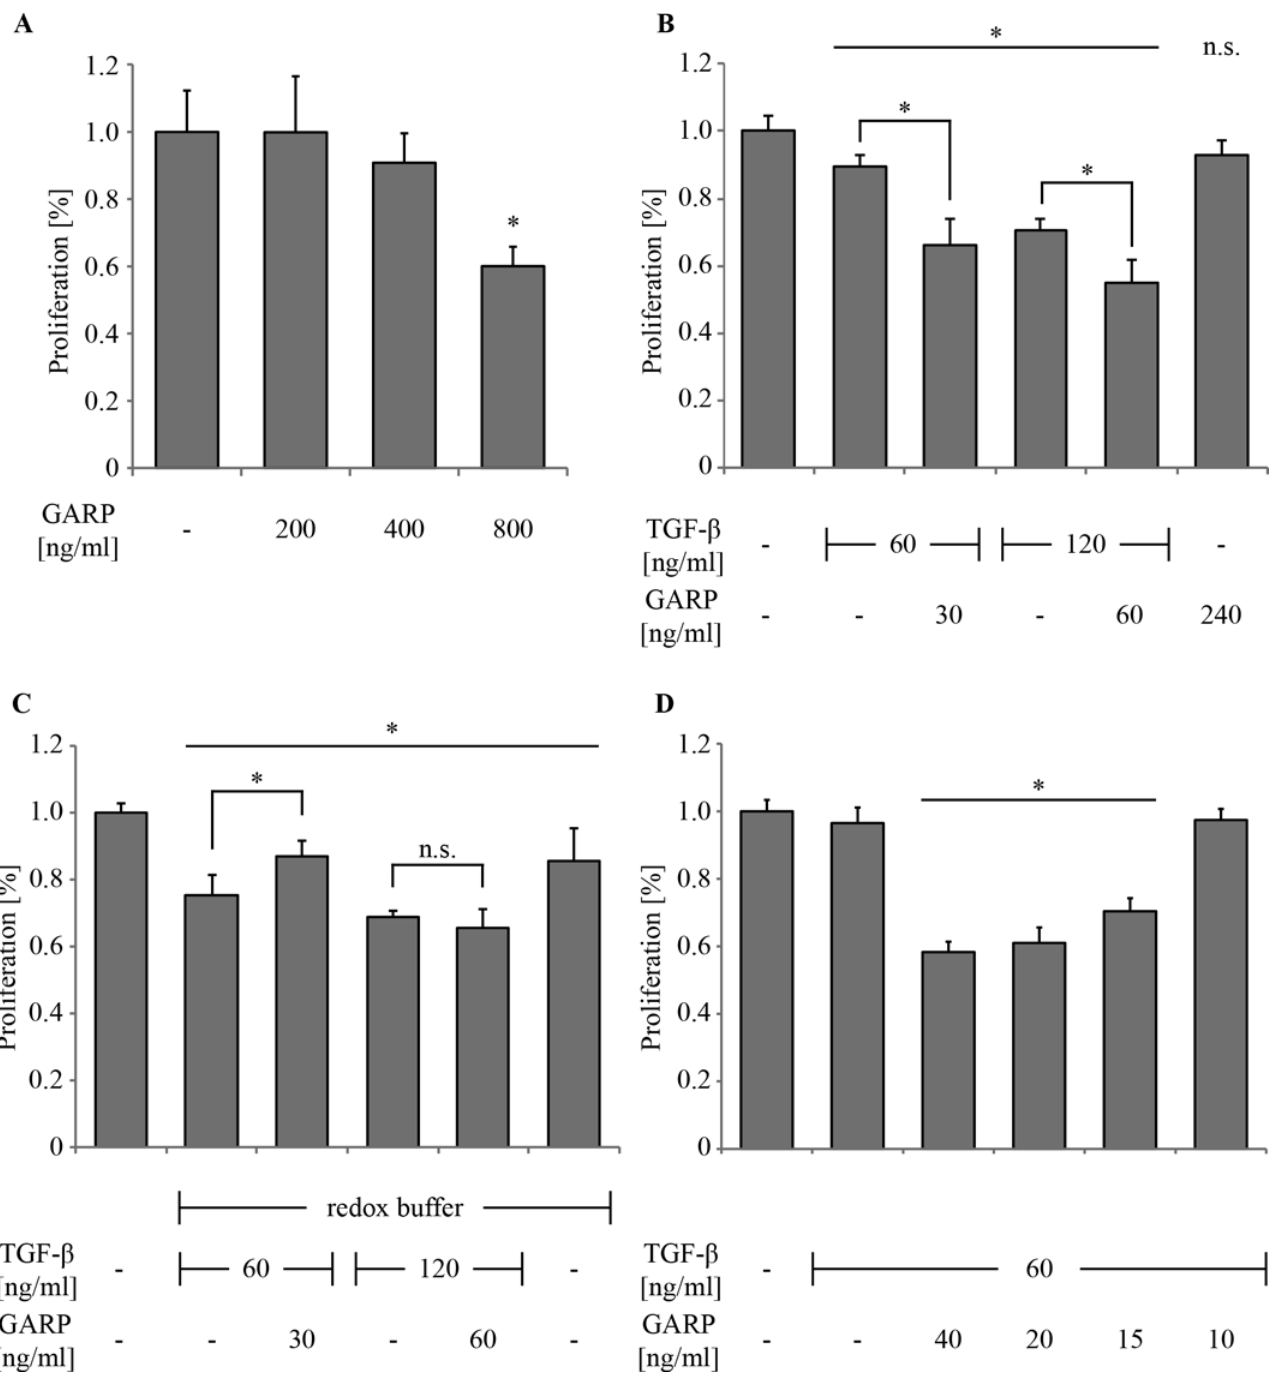
Fig 6. Inhibition of cell proliferation of Mv1Lu cells by GARP and TGF β . Bar diagrams show the proliferation rates (percentage of proliferation, n = 6) of treated versus untreated (100%) Mv1Lu cells. Cell numbers were determined using methylene blue staining of DNA [25]. (A) 2.5 x 10 4 cells were grown for 48h and treated with 200 ng/ml to 800 ng/ml of recombinant GARP TS to determine its influence on cell proliferation alone. (B) Cells were grown for 48h in the presence of the indicated TGF β concentrations pre-incubated with or without the indicated GARP TS concentration. (C) Cells were incubated the same way like in (B), except that the proteins were pre-incubated in redox buffer to provoke covalent bonding of TGF β and GARP (D) 60 ng/ml TGF β were pre- incubated with different amounts of GARP TS (40 – 10 ng/ml) to determine the minimal amount of GARP TS needed to achieve maximal enhancement of TGF β activation. The asterisk ( * ) marks a statistical significance p < 0.01.